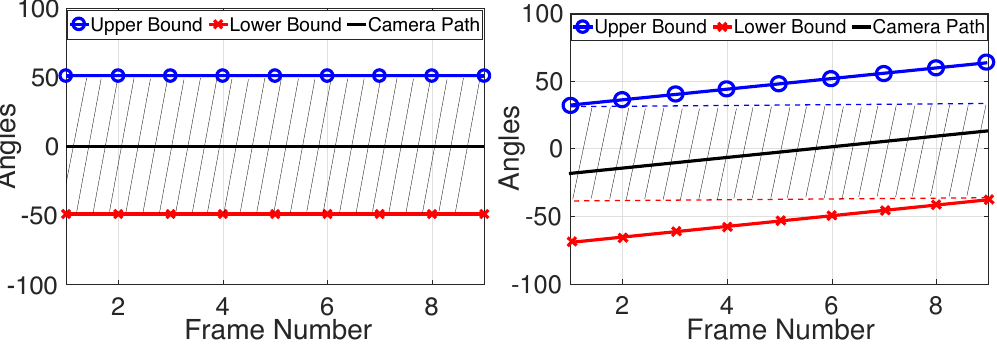
Figure 6. ˜ B ( n ) of zero motion and motion with